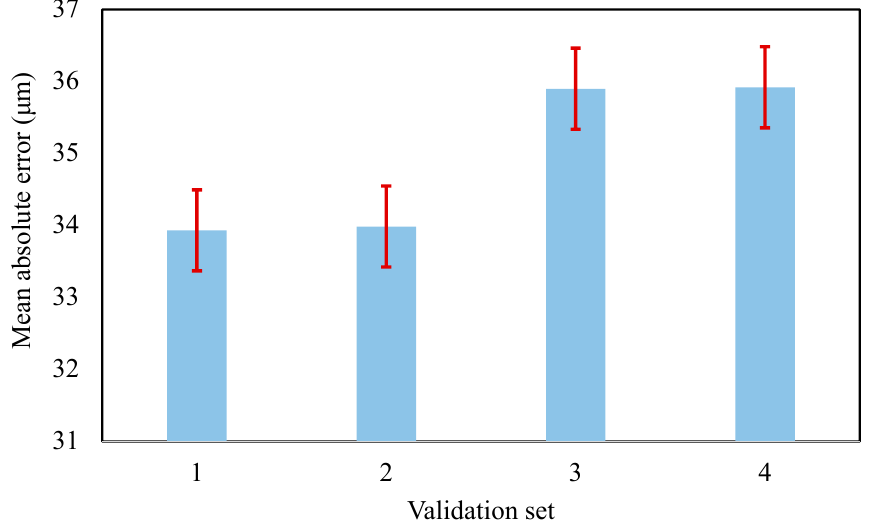
Figure 12. Mean absolute error in four-fold validation set.